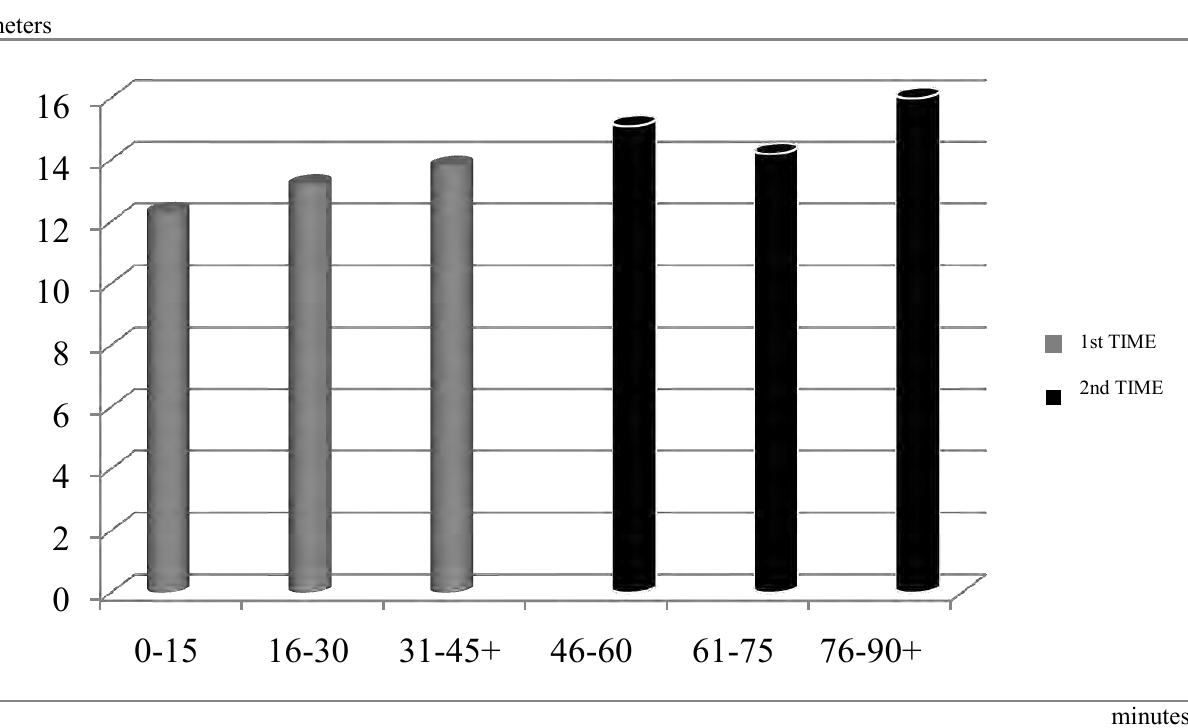
Fig.3 Mean distance from referee to place of rule’s violation (differentiated by 15 minutes’ periods) (in